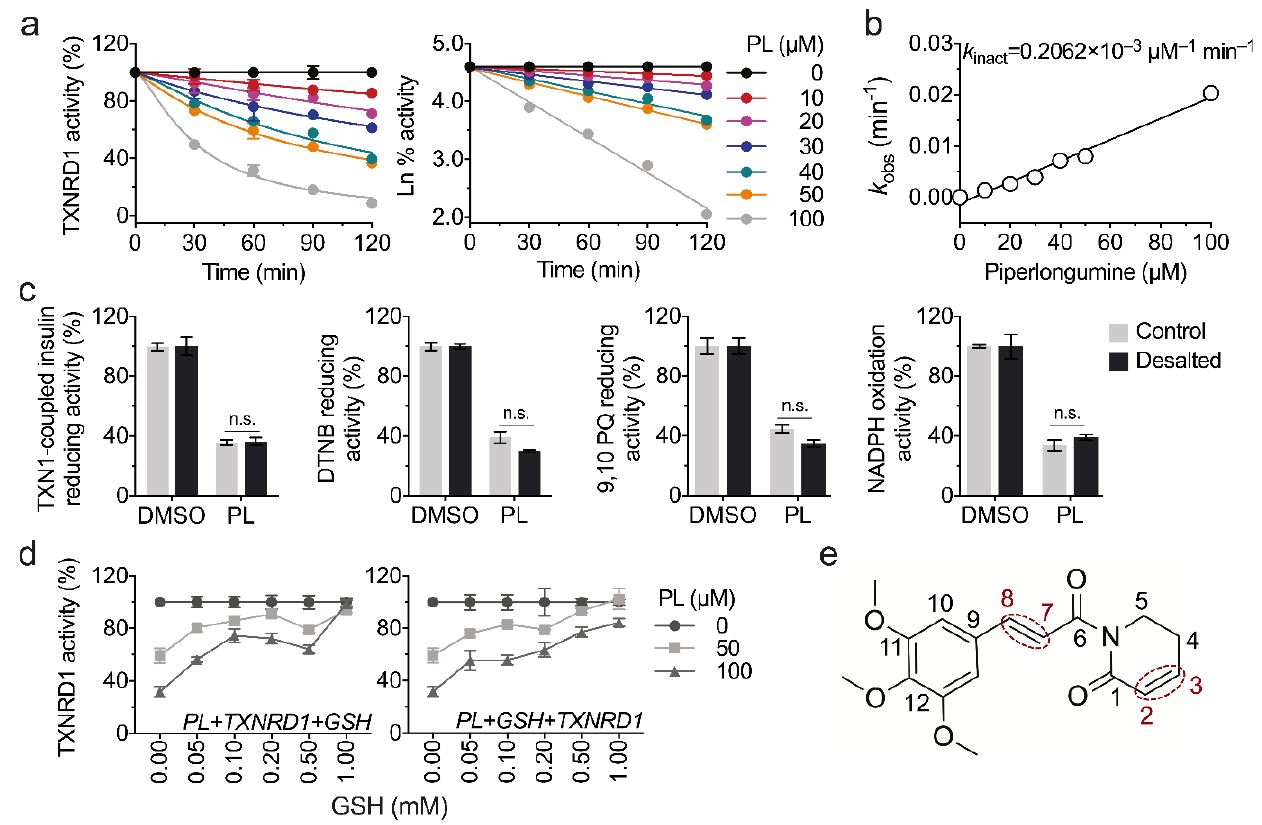
Figure 2. Time-dependent irreversible inhibition of piperlongumine on TXNRD1. ( a ) Piperlongumine inhibits TXNRD1 in a time-dependent manner. TXNRD1 was incubated with different concentrations of piperlongumine for the indicated time. Enzyme activity was measured by DTNB-reducing activity assay. The remaining activity was transformed into the natural logarithm and linear fitted in the right panel. ( b ) Second inhibition rate of piperlongumine on TXNRD1. The slope derived from panel a (right) was plotted versus the concentrations of piperlongumine, and the k incat was calculated from the slope. ( c ) Irreversible inhibition of piperlongumine on TXNRD1. TXNRD1 was incubated with 100 µ M piperlongumine for 60 min. Afterwards, the samples were subjected to NAP TM -5 desalting columns and eluted with fresh TE buffer. Finally, the remaining activities of TXNRD1 in the eluted fractions were measured by using various substrates accordingly. ( d ) GSH protects/rescues the activity loss of recombinant TXNRD1. In the left panel, the mixture contained GSH, piperlongumine, TXNRD1, and NADPH. In the right panel, GSH was pre-incubated with piperlongumine for 10 min and then TXNRD1 and NADPH were added to the mixture. After being incubated for 60 min, the TXNRD1 activity was determined by 9,10 PQ-reducing assay. ( e ) Two reactive α , β -unsaturated olefins of piperlongumine.